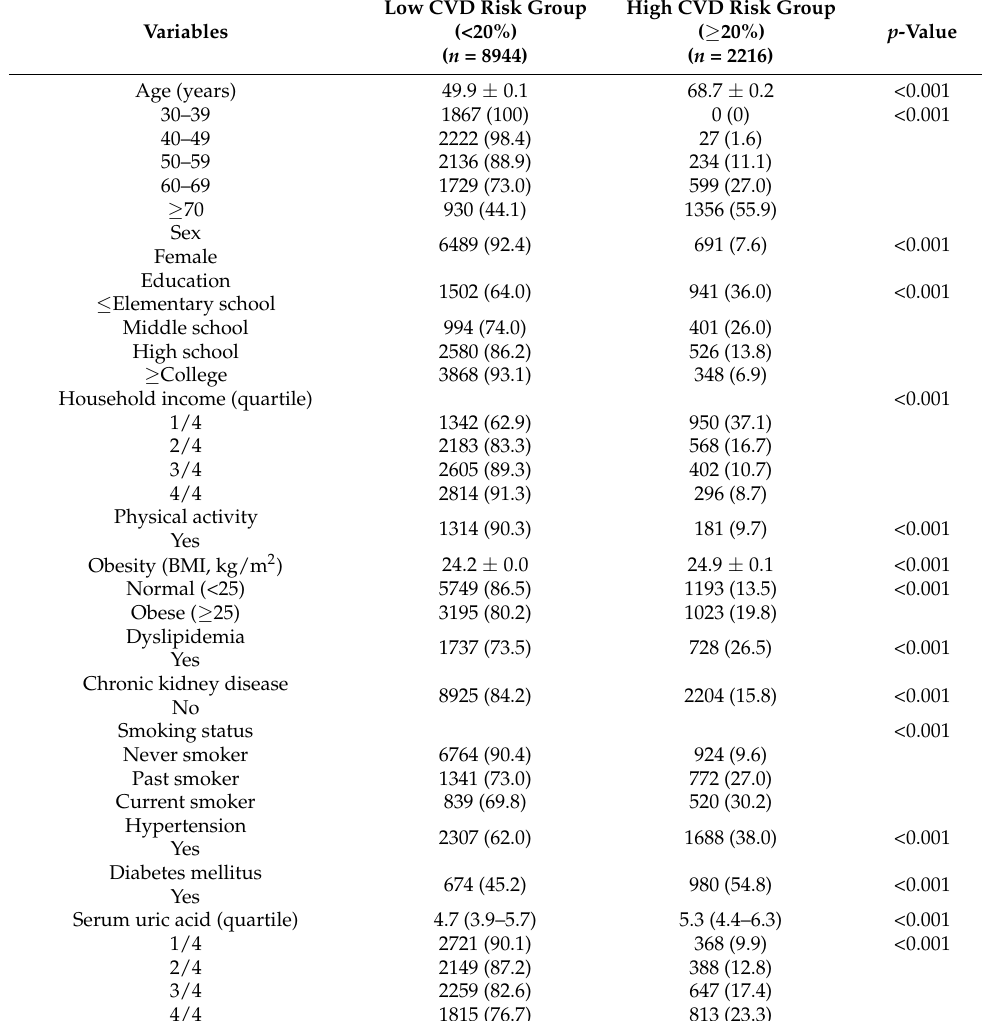
Table 2. Baseline characteristics of the participants according to 10-year cardiovascular disease